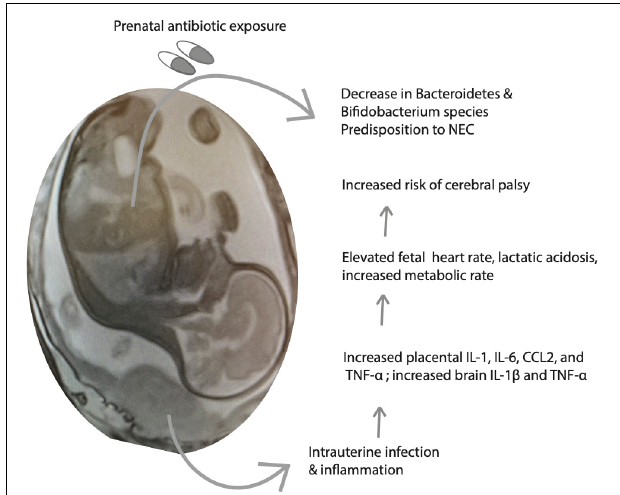
FIGURE 2 | Intrauterine infection and inflammation (III) and treatment with antibiotics alter fetal metabolism. Shown is a schematic of the consequences of III on fetal inflammatory mediators and metabolic parameters, predisposing to increased risk of neurological injury and cerebral palsy. Antibiotics are important to treat the infection, however, they may have untoward consequences on neonatal gut flora maturation.